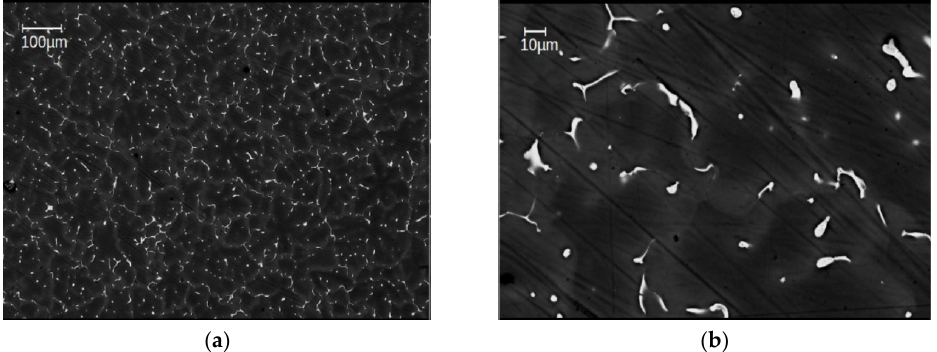
Figure 5. SEM image of the as-cast alloy Mg5Zn0.3Ca, ( a ) with about 100 × magnification ( b ) with about 500× magnification.